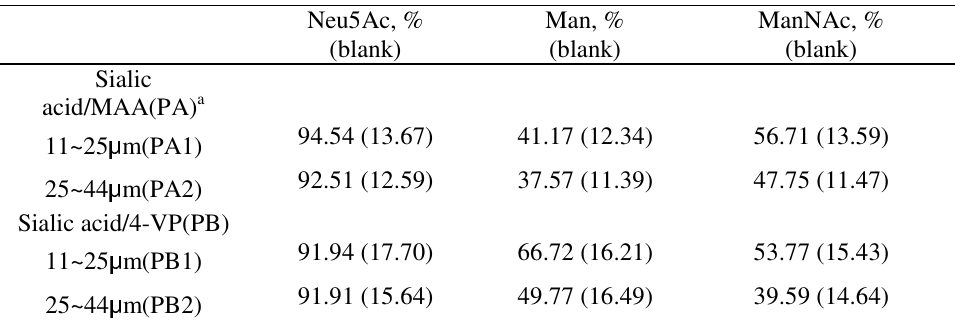
Table 1. Absorptivities b (%) of Neu5Ac, Man and ManNAc from PA1, PA2, PB1, PB2 and non-imprinted polymers.